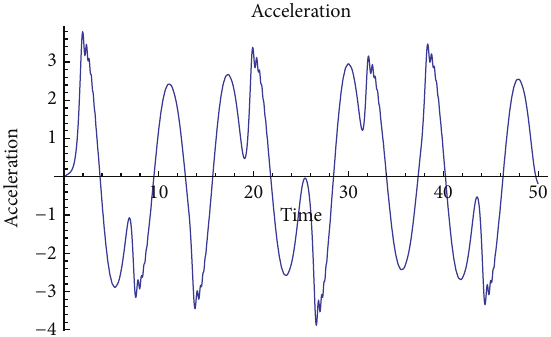
Figure 1: The chaotic progress of acceleration for 𝜀 = 10, 𝐵 = 50, ] = 0 .